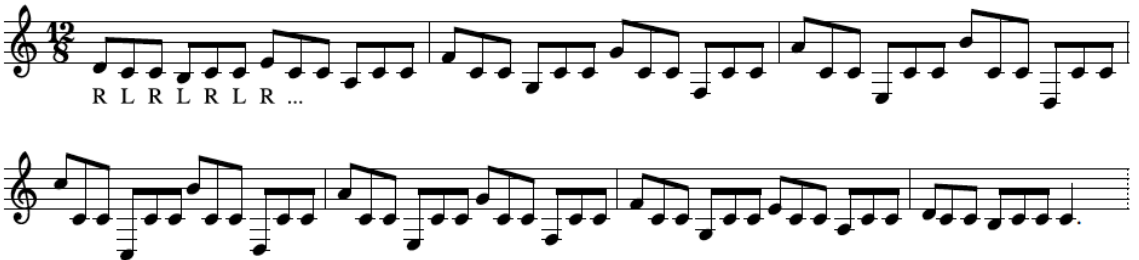
Figure 8. Musical representation of the exercise where Left Hand (L) and Right Hand (R) move progressively away from the central note (C), but constantly having to come back to